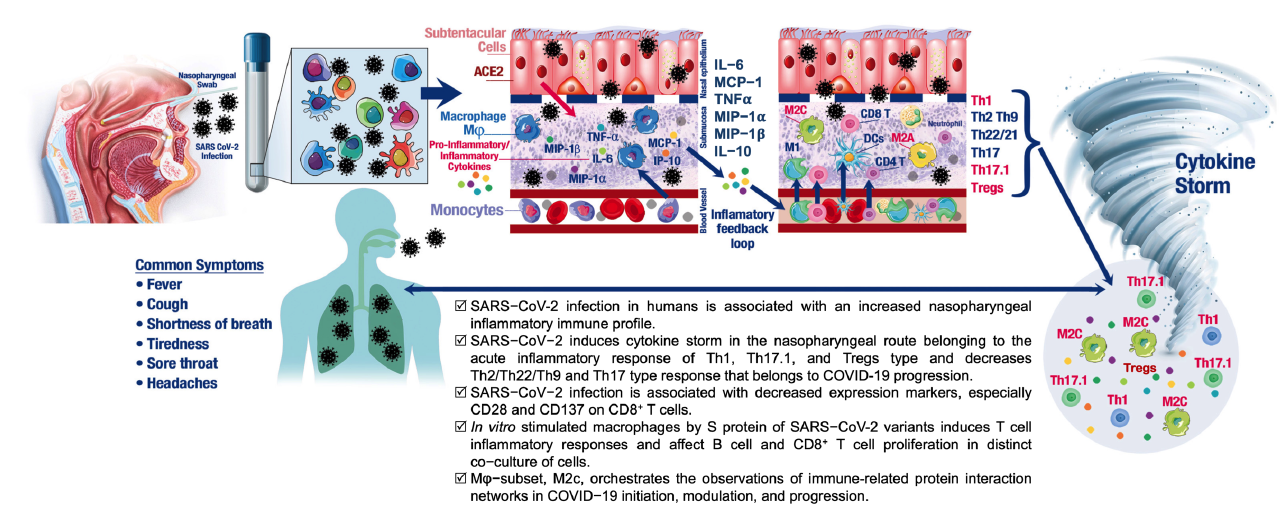
Figure 8. Illustration of the proposed mechanism of disease progression and modulation: Graphical summary. The graph was created with a commercial license from